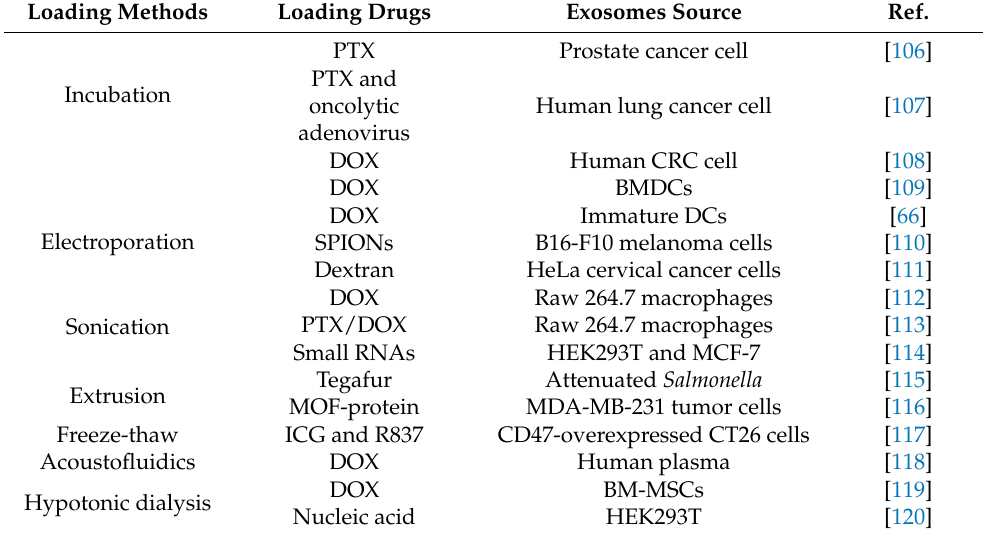
Table 2. Drug-loading methods of